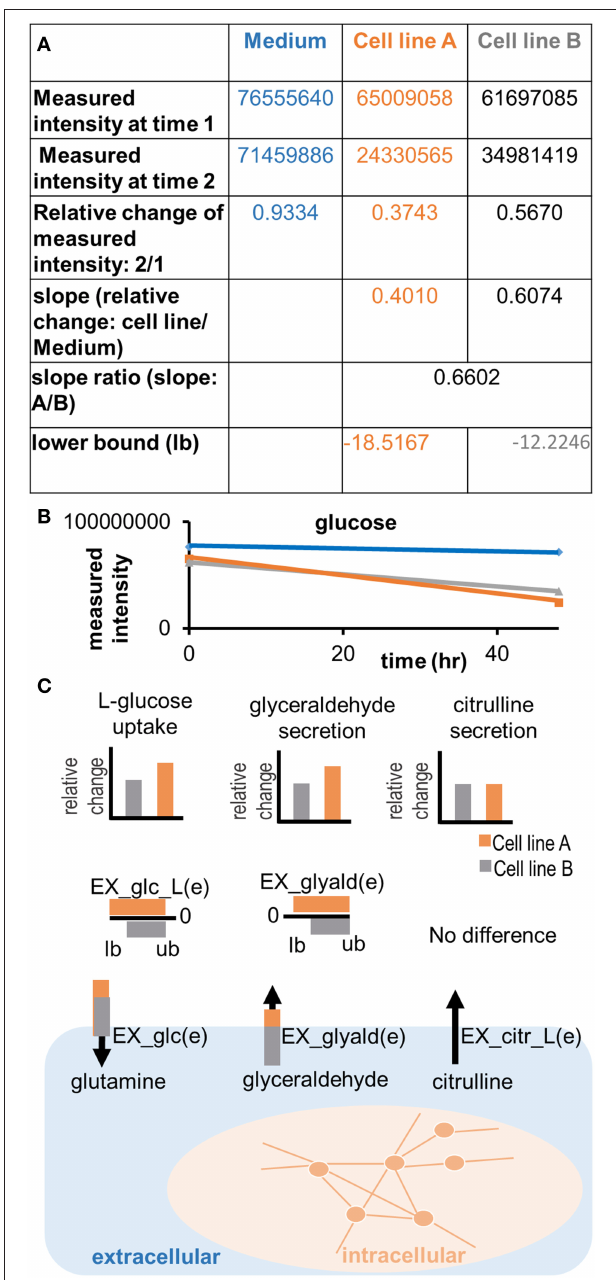
FIGURE 5 | Applying semi-quantitative constraints. Relative differences in the uptake and secretion of metabolites from and into the extracellular medium can be imposed on the models, emphasizing the differences in metabolite uptake and secretion between samples. (A) A slope ratio is calculated based on the data as the relative difference in uptake of a metabolite between two samples and compared to the control (medium). Flux values are in the unit of mmol/g dryweight /hr. The result of the preparation is a set of new lower bounds, which can be applied to the model. Note that the adjusted bound is the gray number, whereas the orange number constitutes the flux value, which was defined based on the medium composition (negative bounds for maximal possible uptake) or based on the minimal detection limits (positive numbers for minimal possible secretion). (B) Illustration of the trend in